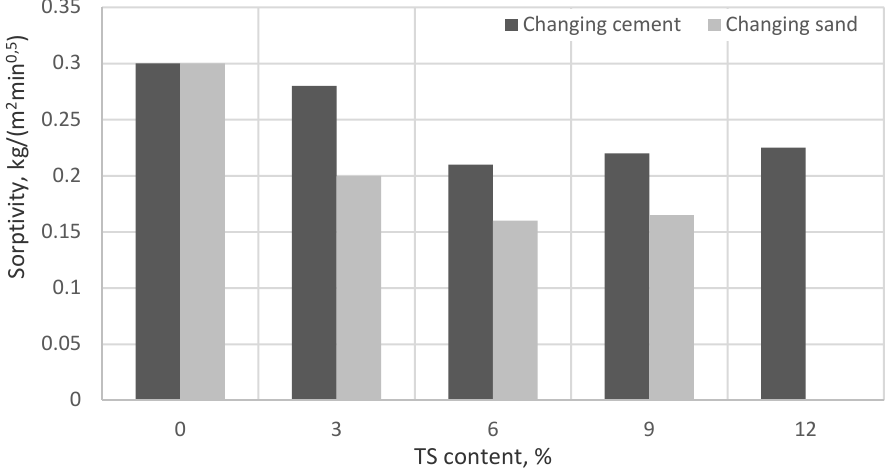
Figure 10. The impact of TS content on sorptivity.